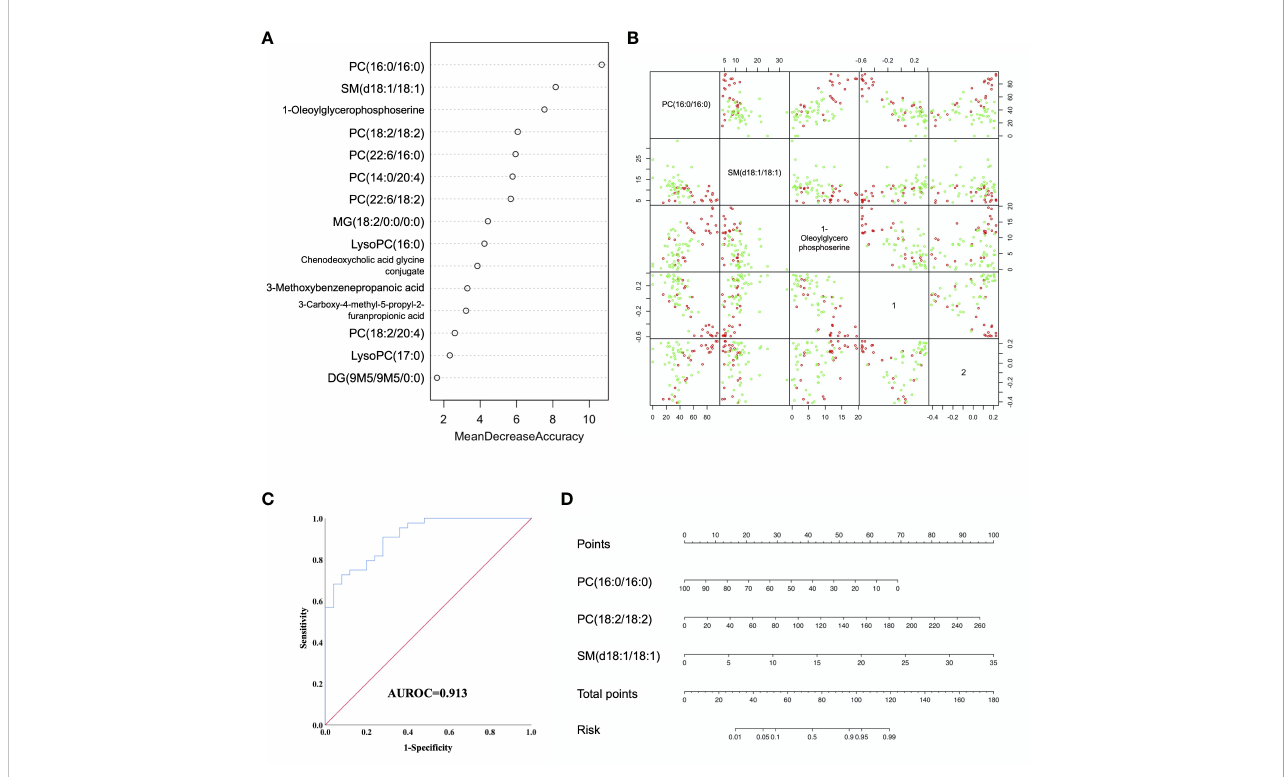
FIGURE 3 Diagnostic model for AFP negative HCC based on Random Forest (RF) analysis. (A) MDA plot of 15 differentially expressed metabolites based on RF analysis between LC and NEG group. (B) Predictors and PCoA plot based on RF analysis, and Scatter plots showing correlation distribution between each feature and PCoA1/2 axes. (C) ROC curve showing the ability of three-marker model to distinguish AFP negative HCC patients from liver cirrhosis patients. (D) Diagnostic nomogram for AFP negative HCC based on the three-marker